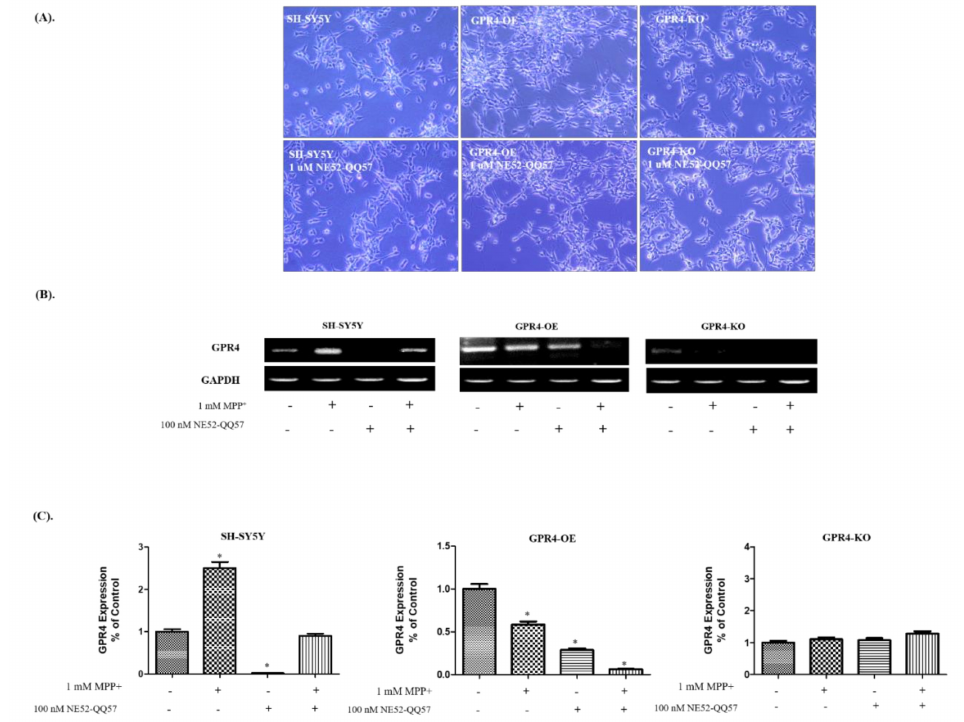
Figure 4. The e ff ect of GPR4 antagonist, NE52-QQ57, on the cellular morphology and on GPR4 mRNA expression in MPP + -treated SH-SY5Y cells that were stably GPR4-OE or GPR4-KO. 24 h serum-starved SH-SY5Y cells were treated for 1 h with NE52-QQ57 followed by either a 24 h incubation or MPP + (1 mM) stimulation for 24 h in serum-free culture media. ( A ) The cell viability and morphology of SH-SY5Y, GPR4-OE, and GPR4-KO cells that were pre-treated for 1 h with NE52-QQ57. ( B ) An RT-PCR highlighting the mRNA expression of GPR4 and GAPDH in SH-SY5Y, GPR4-OE, and GPR4-KO cells pre-treated for 1 h with NE52-QQ57. ( C ) A semi-quantification of GPR4 mRNA expression relative to GAPDH. This semi-quantification of the respective mRNA expression levels was performed on ImageJ software; GAPDH was utilised as an internal control. Mean ± SEM ( n = 3) was employed to express the data. Tukey’s multiple comparison test was performed using a one-way ANOVA. Each * p < 0.05 refers to the sample concentration compared with the same group of non-treated